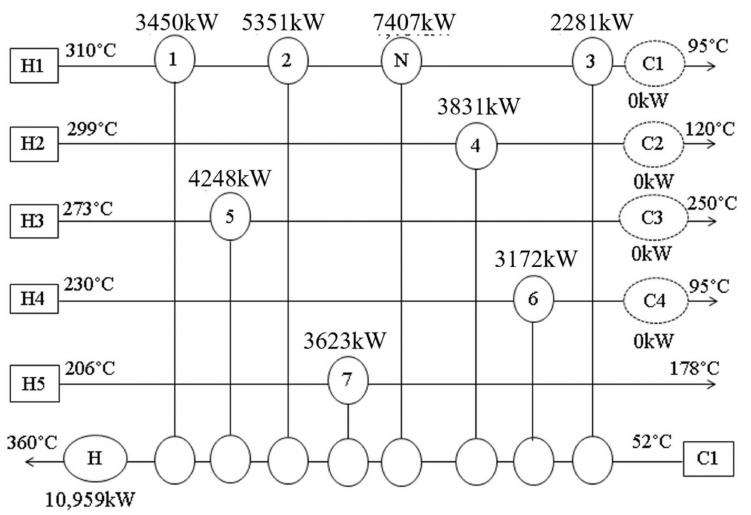
Figure 17. The best retrofit solution for case study 2.